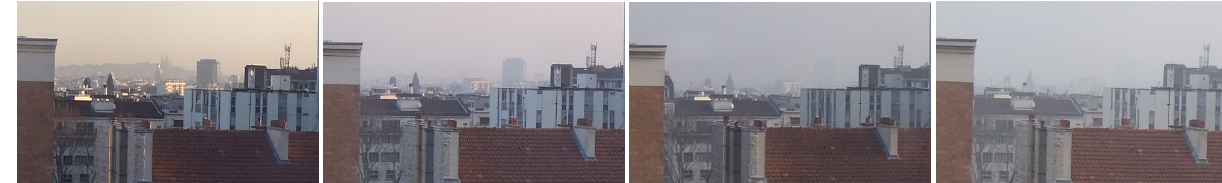
Figure 1: Contrast fading on the same scene due to various values of the extinction coefficient β